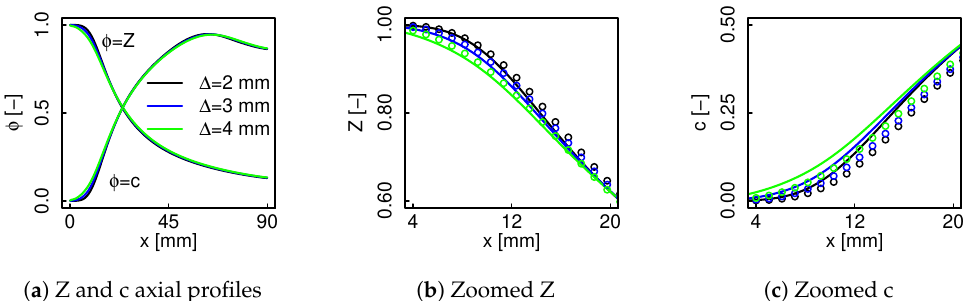
Figure 6. Filtered axial profiles of mixture fraction and progress variable ( a ); zoom of region with bigger filter effect for Z ( b ) and for c ( c ). Solid lines represent the filtered tabulated chemistry results, circles correspond to the filtered reference